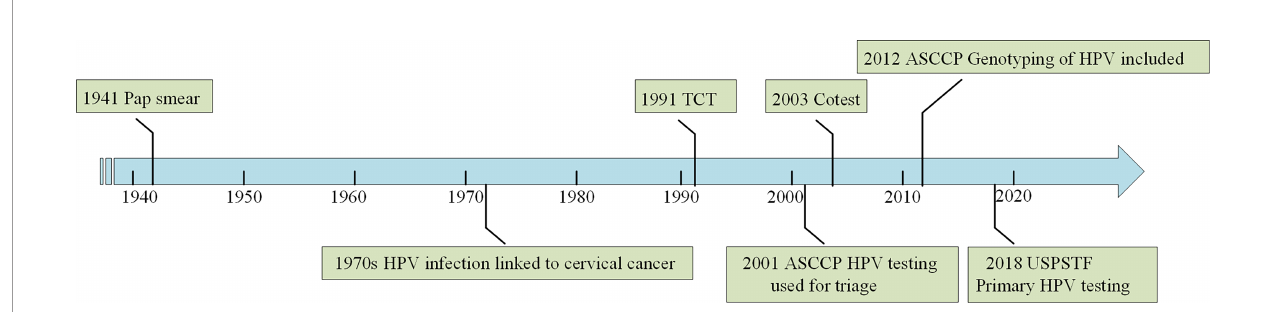
FIGURE 1 | Evolution of cervical cancer screening methods. The fi gure shows major milestones in the evolution of cervical cancer screening. The main screening methods for cervical cancer are HPV testing and TCT (cytology)